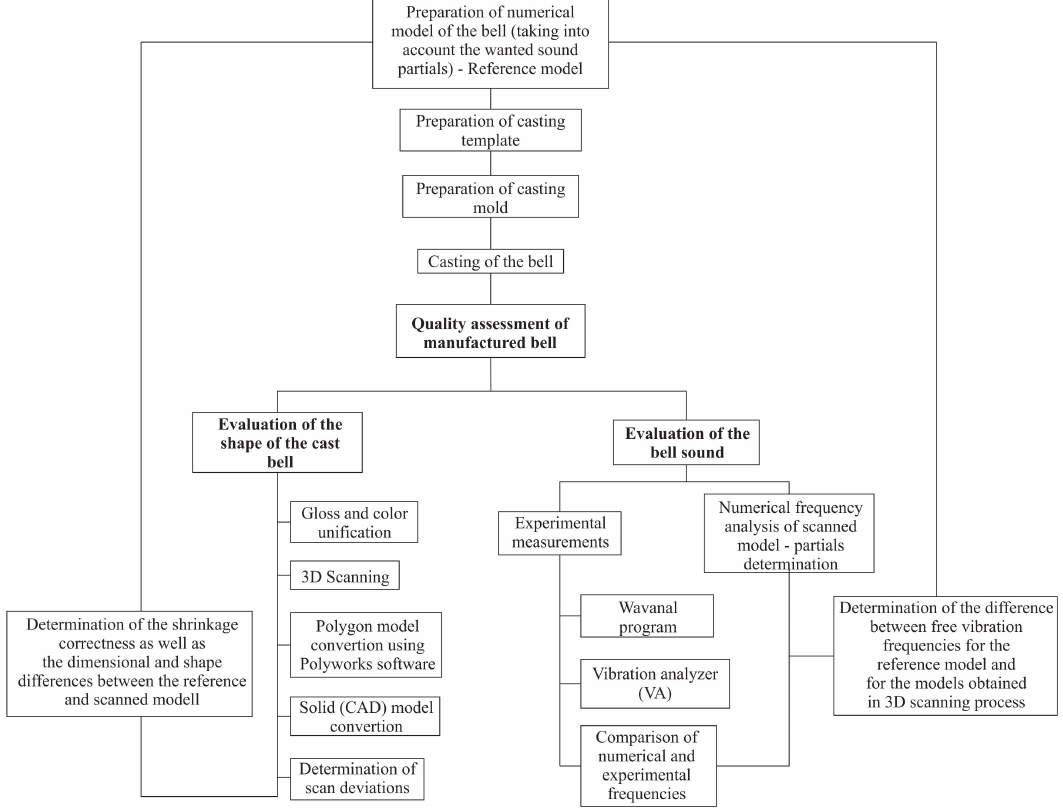
Figure 1. Flowchart of the bell quality